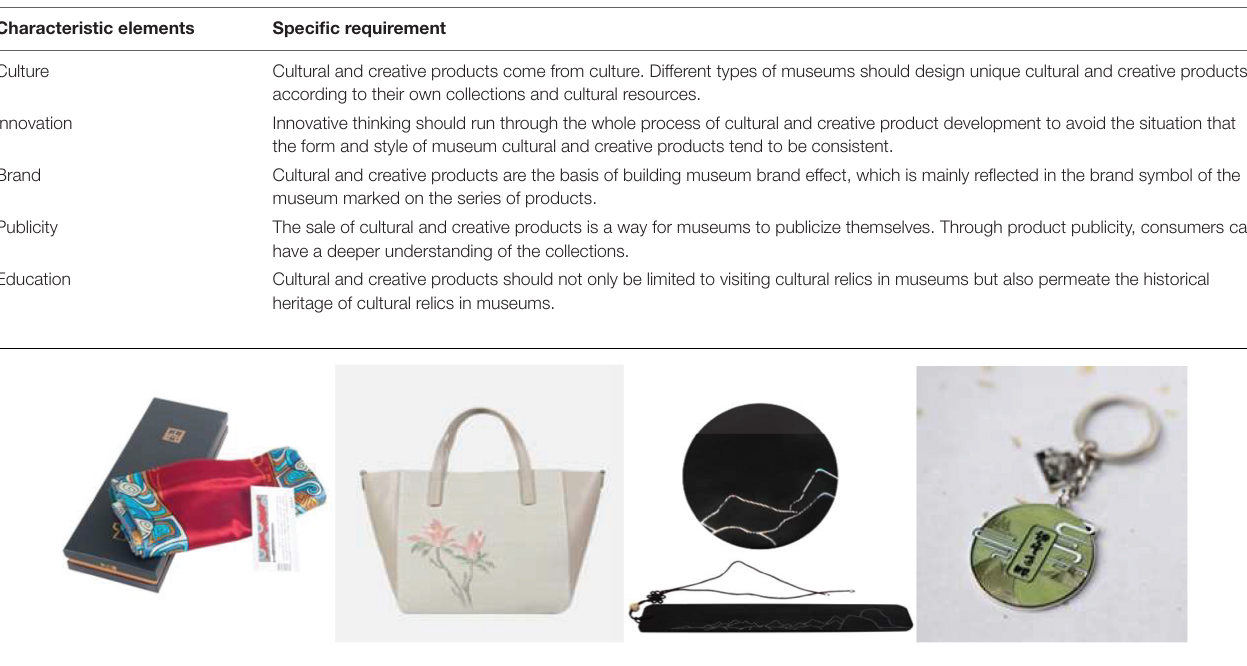
TABLE 1 | Five elements of museum cultural and creative product development.